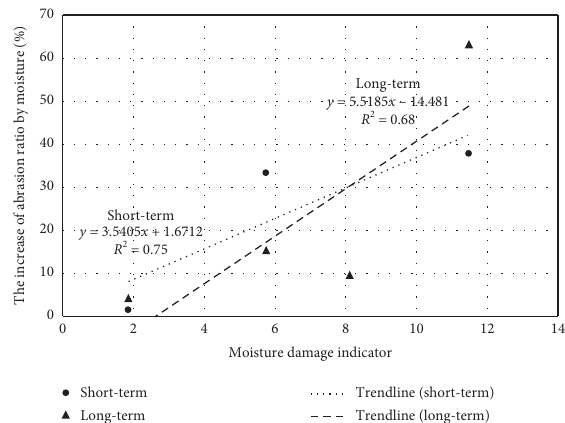
Figure 12: Correlation between the increase in the abrasion ratio with moisture and moisture damage indicator for short- and long- term